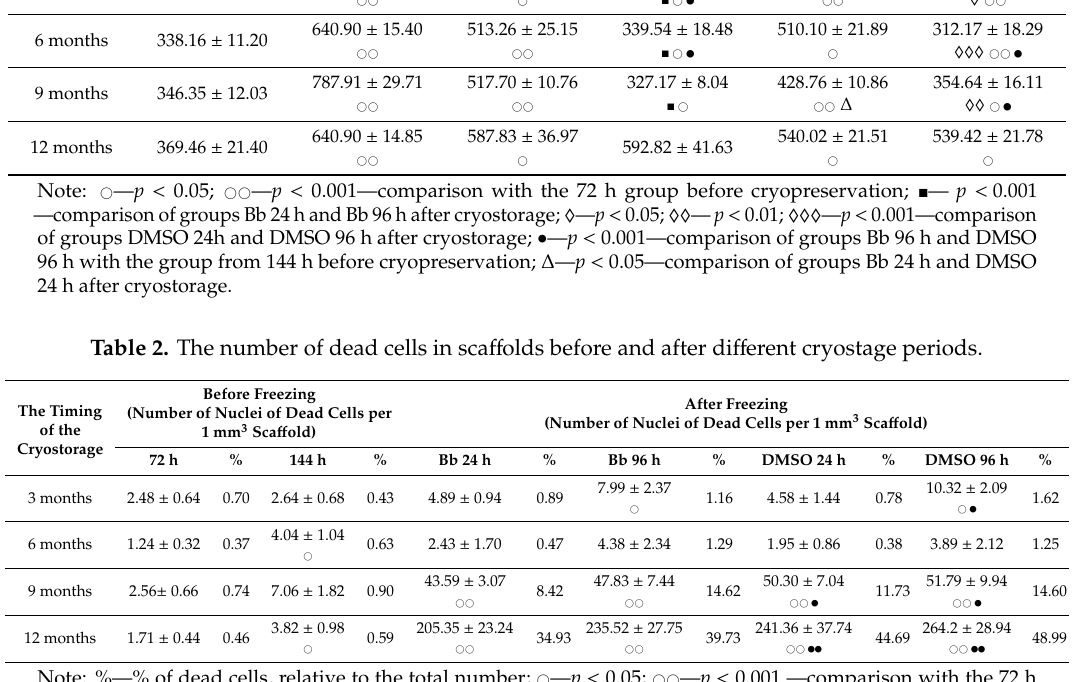
Table 1. The number of cells in sca ff olds before and after di ff erent cryostage periods. The Timing of the Cryostorage